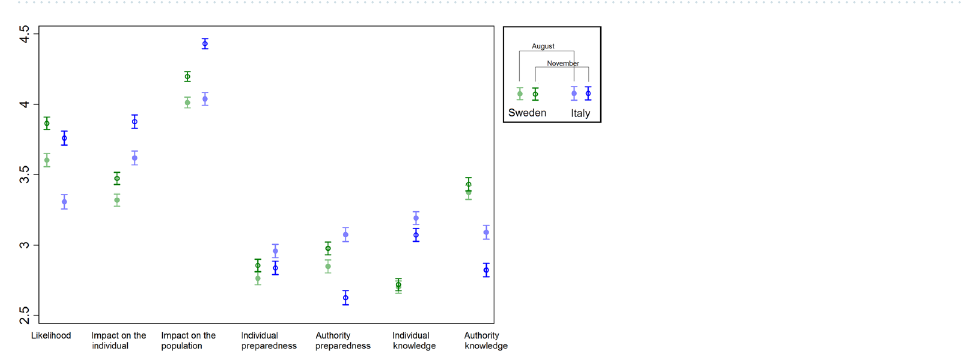
Figure 1. Mortality rate and daily occupancy of intensive care unit rate for COVID-19 per 100,000 individuals and the level of restrictive measures—the Stringency Index—in Italy and Sweden during 2020. The Stringency Index considers 9 domains (school closures, workplace closures, cancellation of public events, restrictions on public gatherings, closures of public transport, stay-at-home requirements, public information campaigns, restrictions on internal movements, and international travel controls).